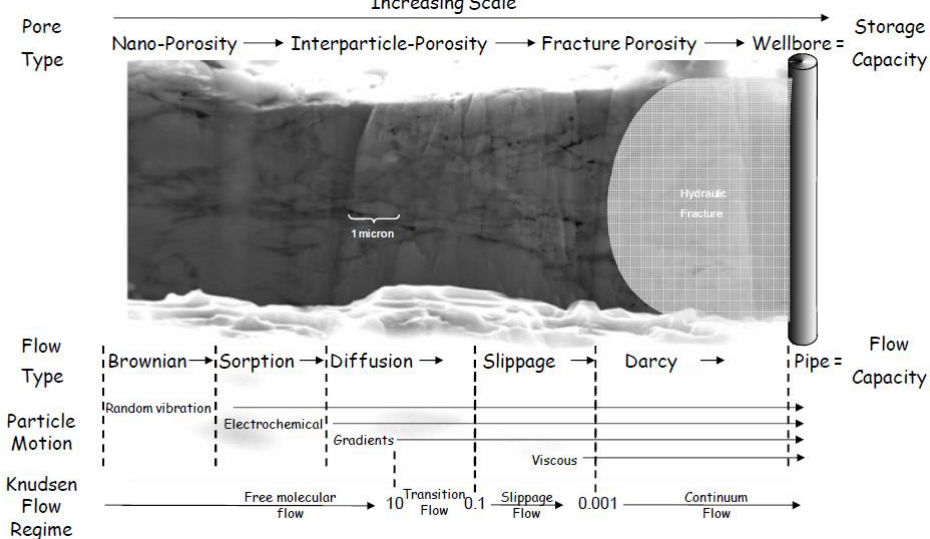
Figure 6. Flow types, particle motion within a given flow regime. The cross sectional image is a SEM image of a shale gas sample. Reprint with permission [84], 2010, Society of Petroleum